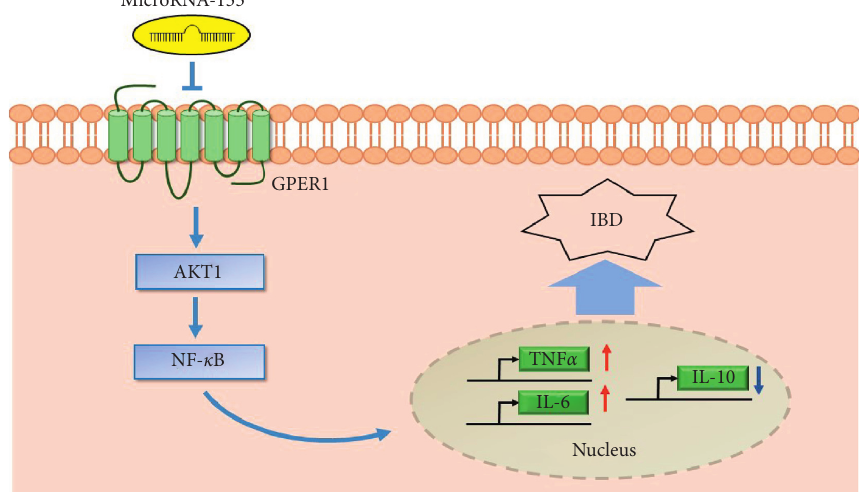
Figure 5: MiR-155 plays a proinflammatory role, and GPER1 is anti-inflammatory during the pathogenesis of IBD. In IBD patients, the proinflammatory cytokines IL-6 and TNF α were significantly higher, and the anti-inflammatory cytokine IL-10 was significantly